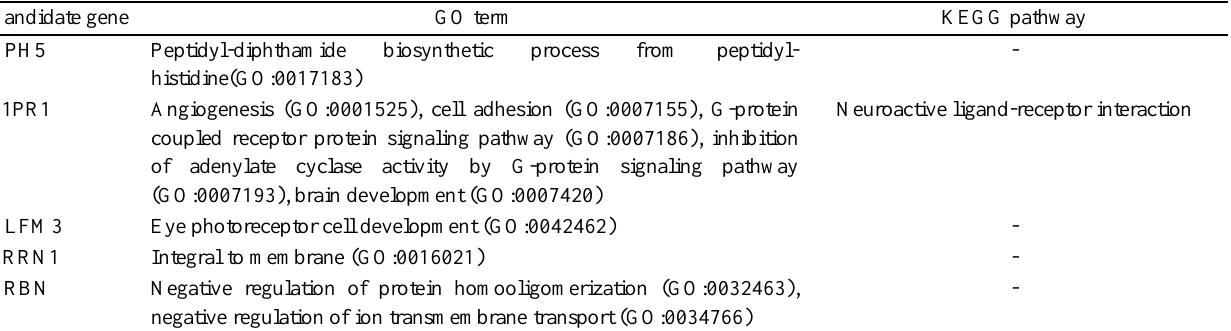
Table 2. Gene Ontology and KEGG pathway of the candidate genes showing evidence for selection signatures Candidate gene GO term KEGG pathway DPH5 Peptidyl-diphthamide biosynthetic